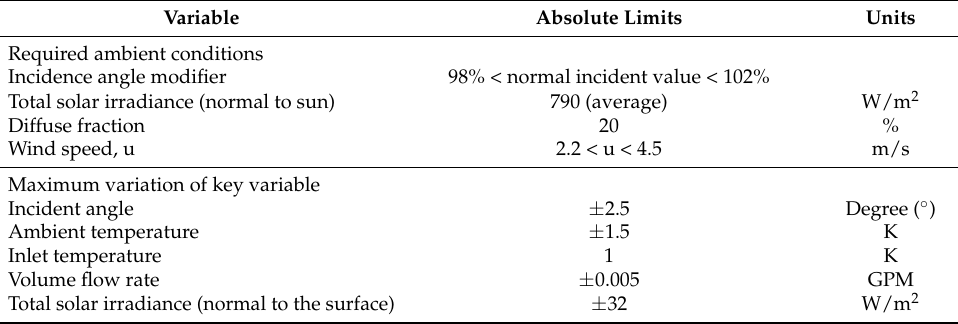
Table 2. ASHRAE standard parameters for steady-state